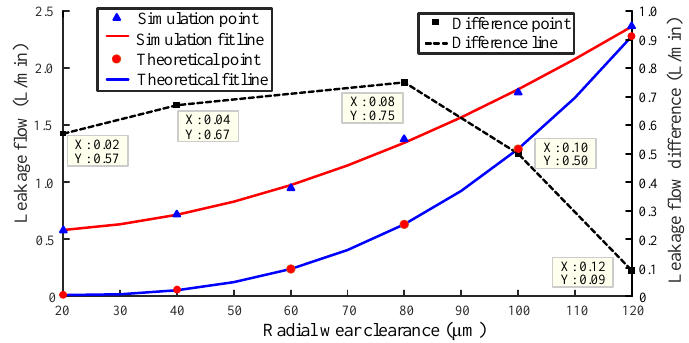
Figure 16. Fitting line of radial wear clearance and leakage.